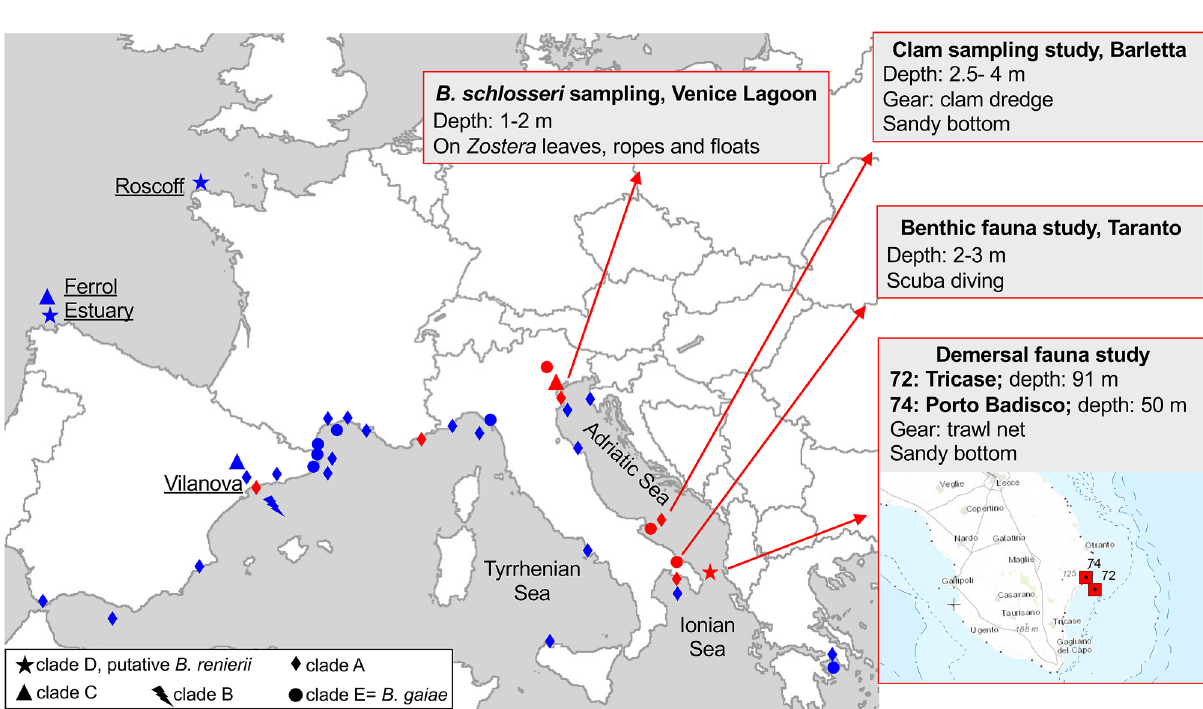
Figure 4. Distribution of the former clades of B. schlosseri species complex in the Mediterranean Sea, and presence of the rare clades along the European Atlantic coasts. Red: this study, with localities and dates of our samplings detailed in Supplementary Table S1; blue: data from literature 9,18,19,32,33 . Notes: in Reem et al. 33 clade E is reported as clade IV, while clade A includes the clades I, II, and III; localities Fornelos and Ferrol cited in Lopez-Legentil 18 and Pérez-Portela 19 , respectively, are here reported as "Ferrol Estuary", according to the data provided by the authors (Turon X, personal communication). Indeed, Fornelos is one of the marinas in the city of Ferrol, inside the Ría de Ferrol, while Ferrol is a natural environment at the entrance of the estuary. The map was created with ArcView GIS 3.2 (https